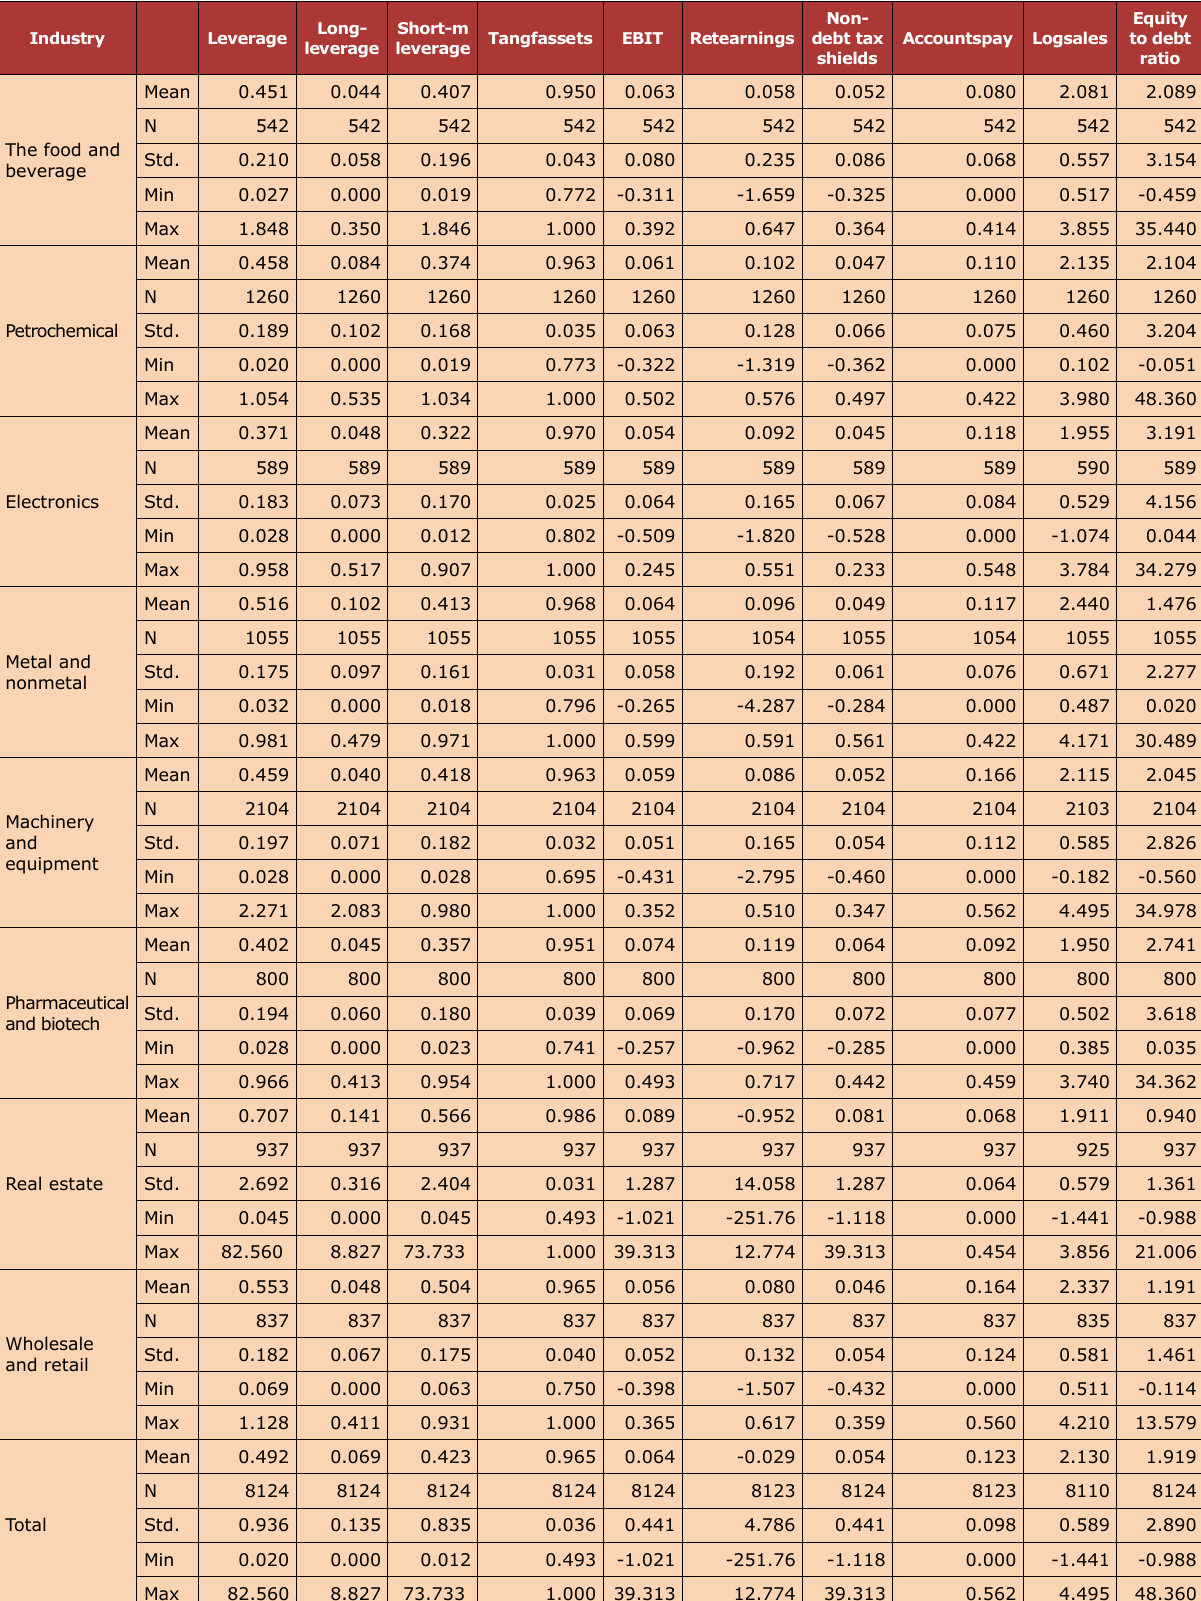
Table 4. The descriptive statistics of the financial indicators panel data in different